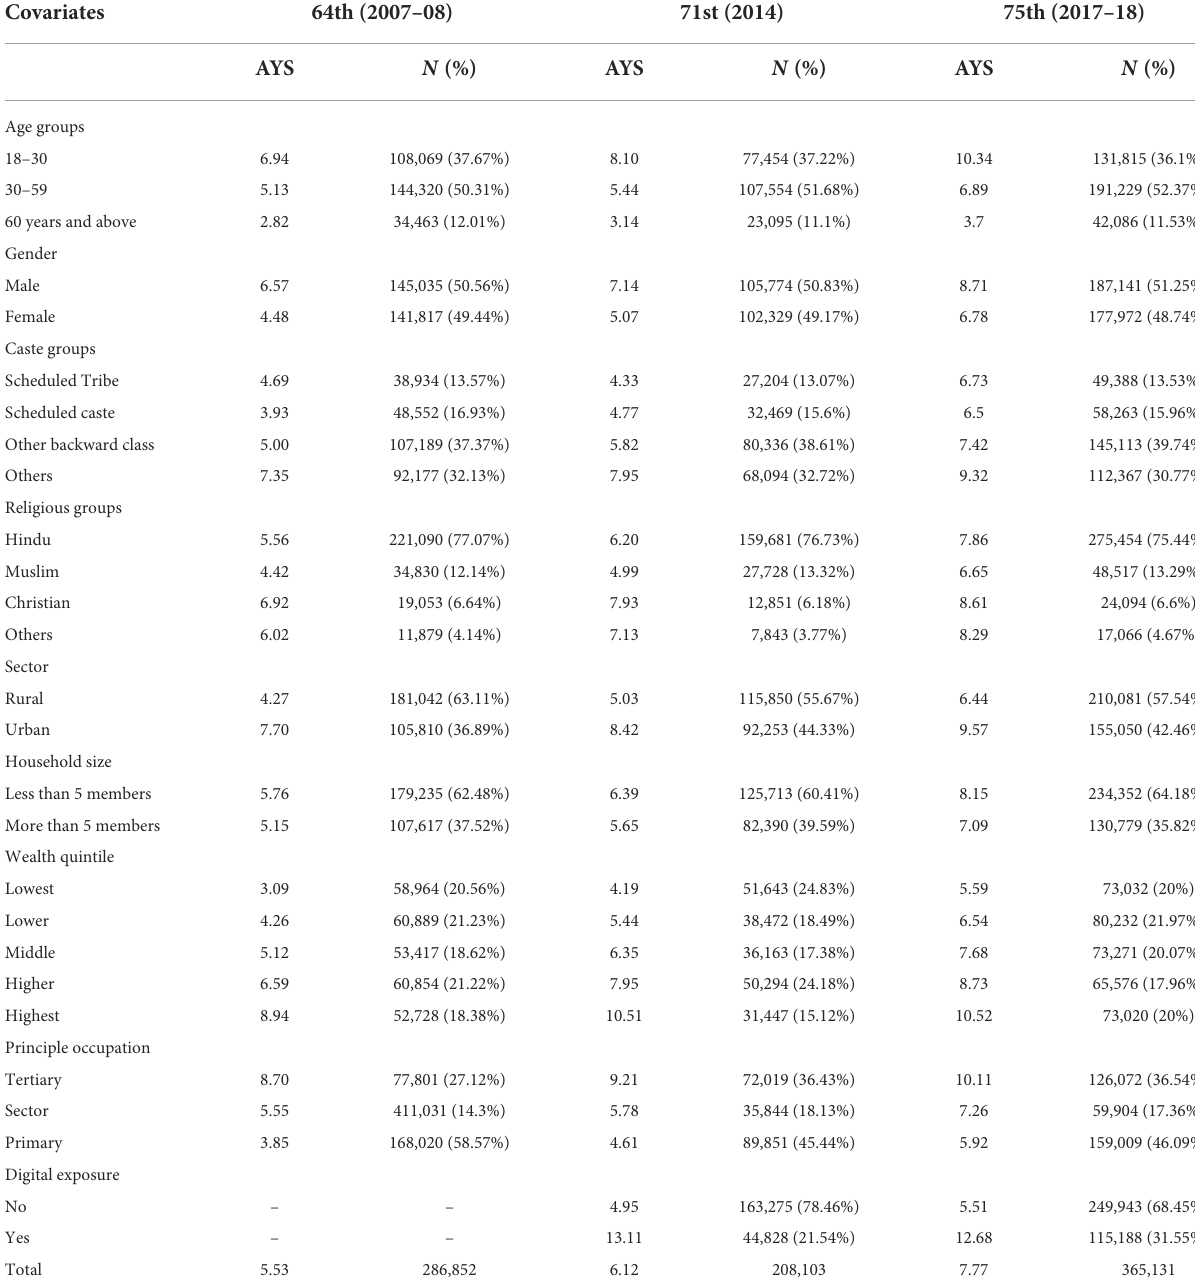
TABLE 3 Background characteristics of population 18 years and